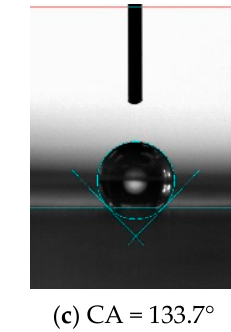
Figure 16. Hydrophobic characteristics of microstructures with different tilt angles when the mi- crostructure width is 100 μ m. ( a ) 90°; ( b ) 45°; ( c ) 30°.